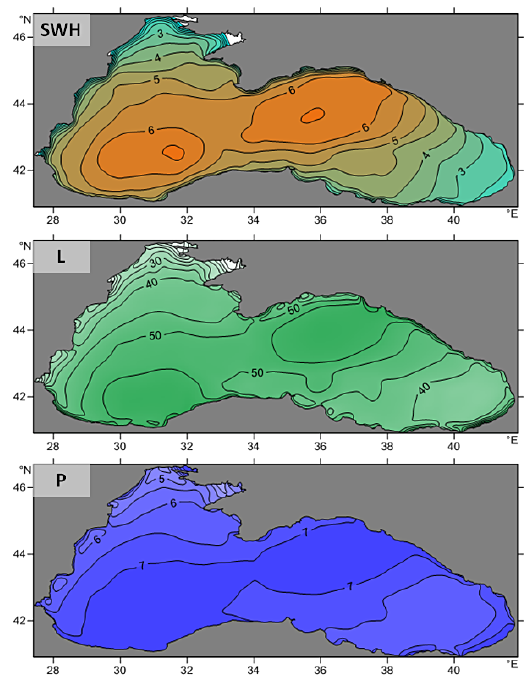
Figure 14. Maps of calculated significant wave height [m], wave length [m] and period [s] maxima.